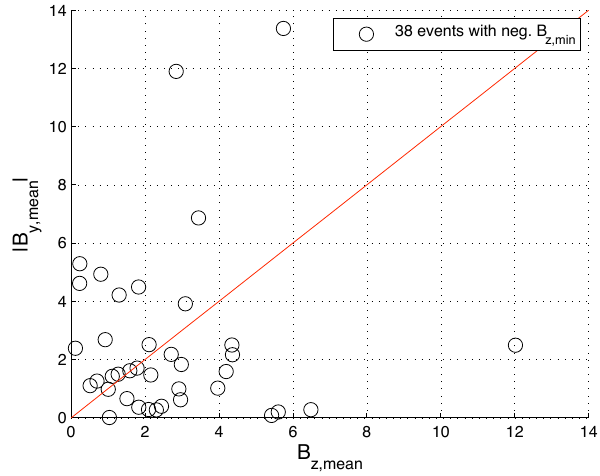
Fig. 4. The relation between the mean of the magnetic field in y- direction, | B y , mean | and z-direction, B z , mean of the 38 dipolariza- tion events with a negative B z , min (black circles). The mean magni- tudes are evaluated during the steady state before the dipolarization is about to